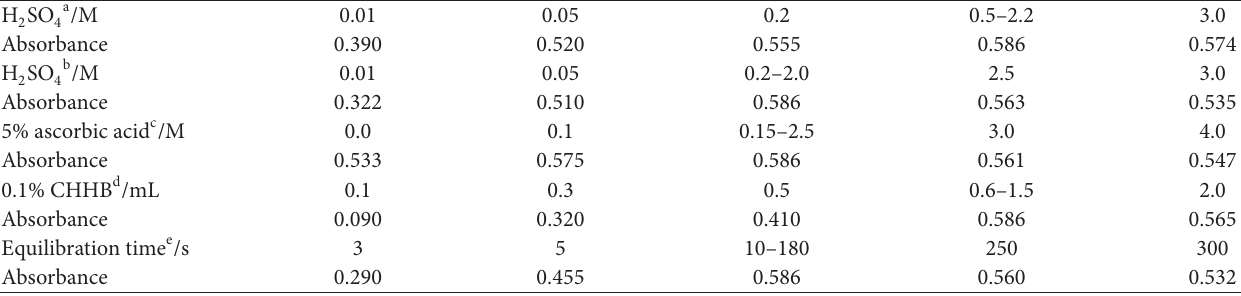
T 1: Effect of various parameters on the absorbance of Mo(V)-CHHB complex.